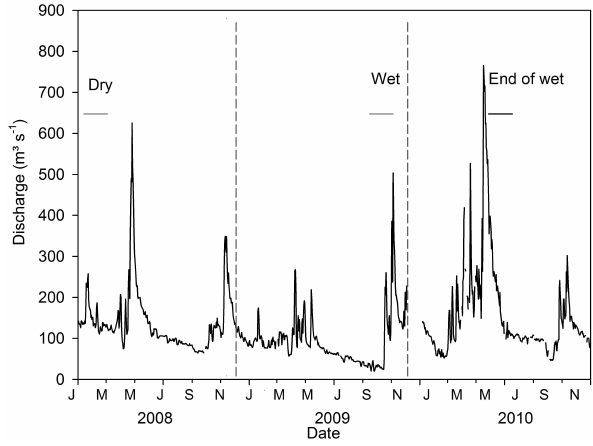
Fig. 3. Discharge measurements for the Tana River (2008–2010) as recorded at Garissa station. (Data source: Water Resource Manage- ment Authority.) Horizontal lines indicate the duration of the three field investigations, while vertical dashed lines separate different years. Dry season data have already been presented in Bouillon et al.